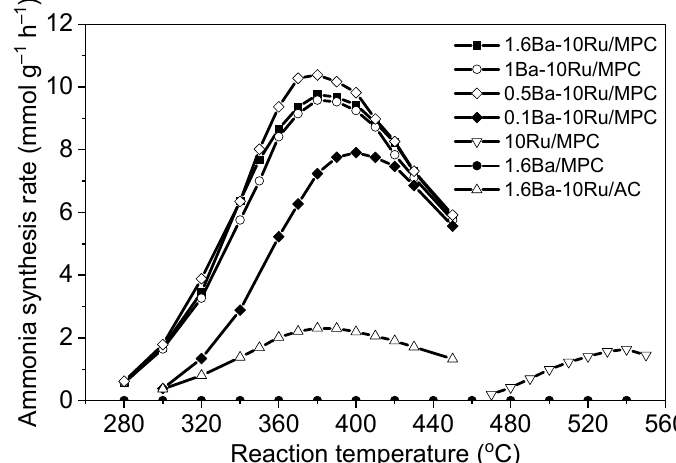
Figure 4. Rate of ammonia synthesis as a function of reaction temperature over the 0.1–1.6Ba-10Ru / MPC and reference catalysts. Table 2. Catalytic performance of the prepared Ba-Ru catalysts and reference materials for ammonia synthesis.